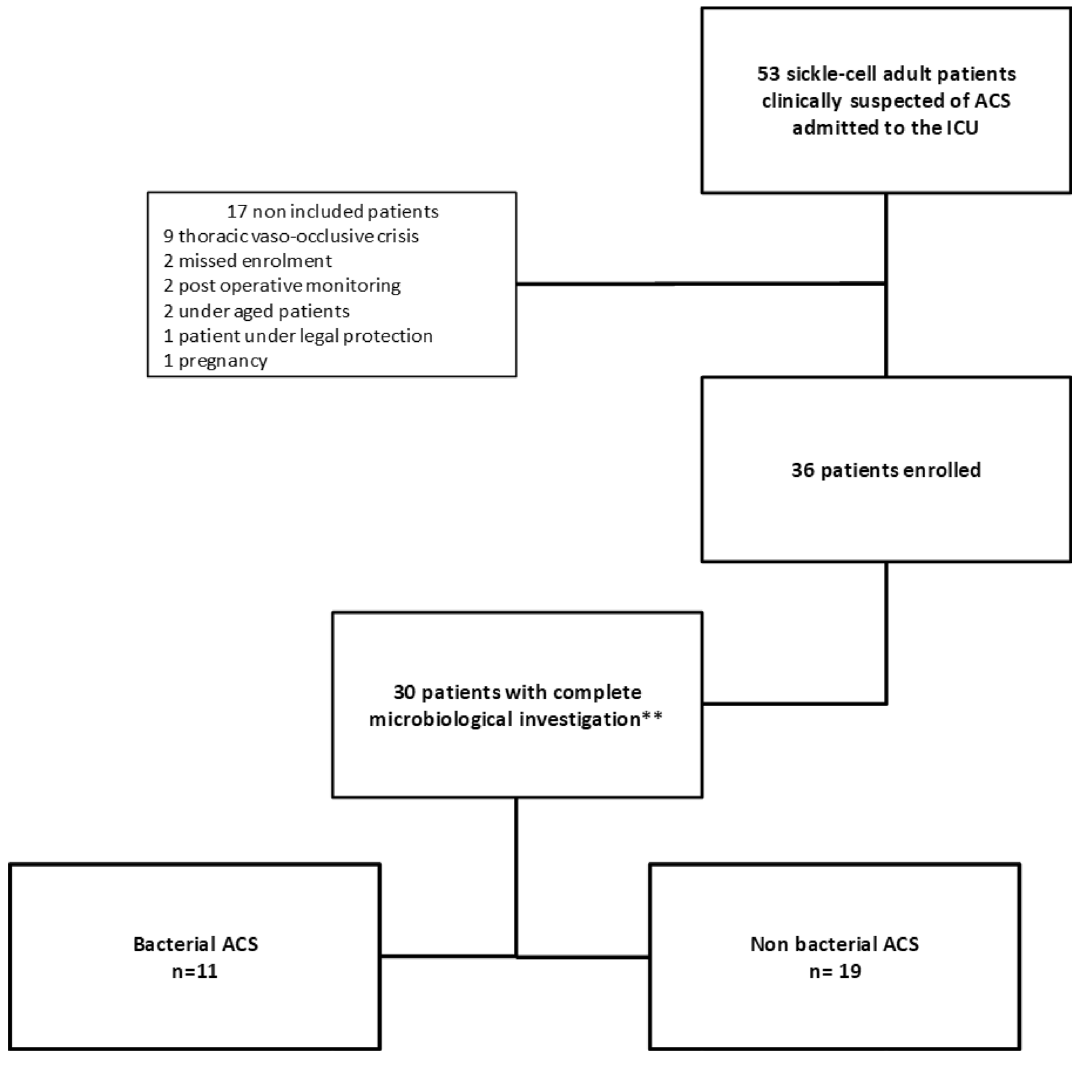
Figure 1. Selection of the